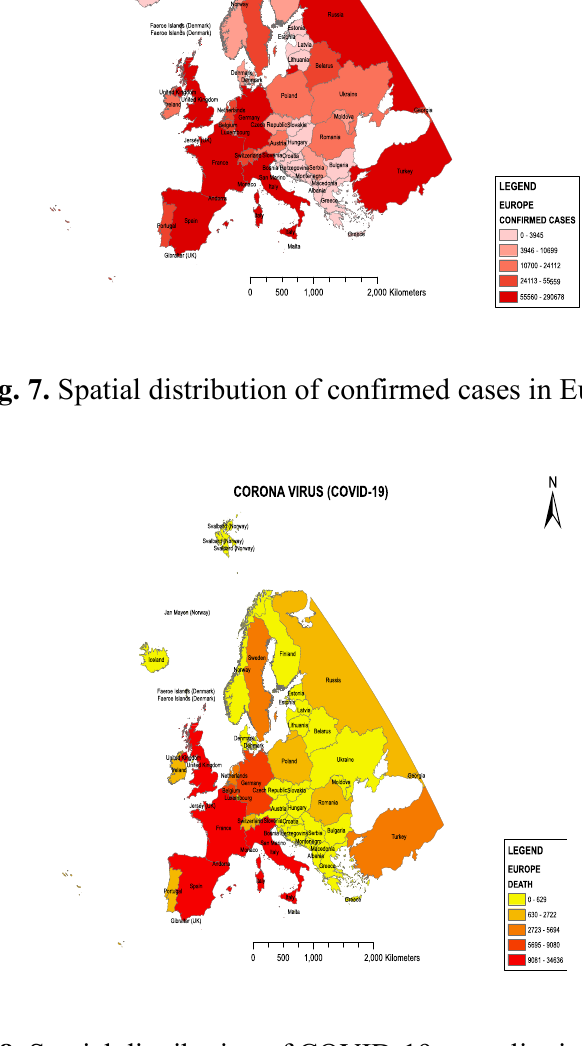
Fig. 8 . Spatial distribution of COVID-19 mortality in